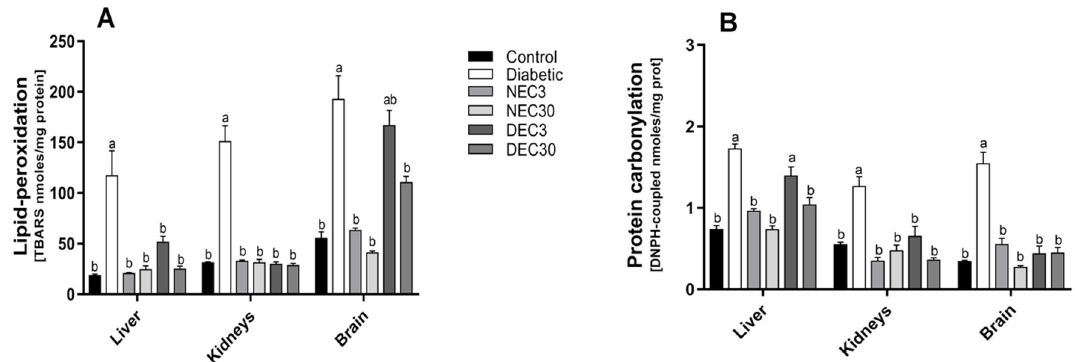
Figure 2. Eryngium carlinae extract effects on oxidative modifications in the liver, kidneys, and brain. The results represent the means ± SE of three independent experiments of the ( A ) lipid peroxidation effect and ( B ) protein carbonylation content. Different letters indicate significant differences ( p ≤ 0.05) between treatments, based on two-way ANOVAs with Tukey’s post hoc test. NEC: